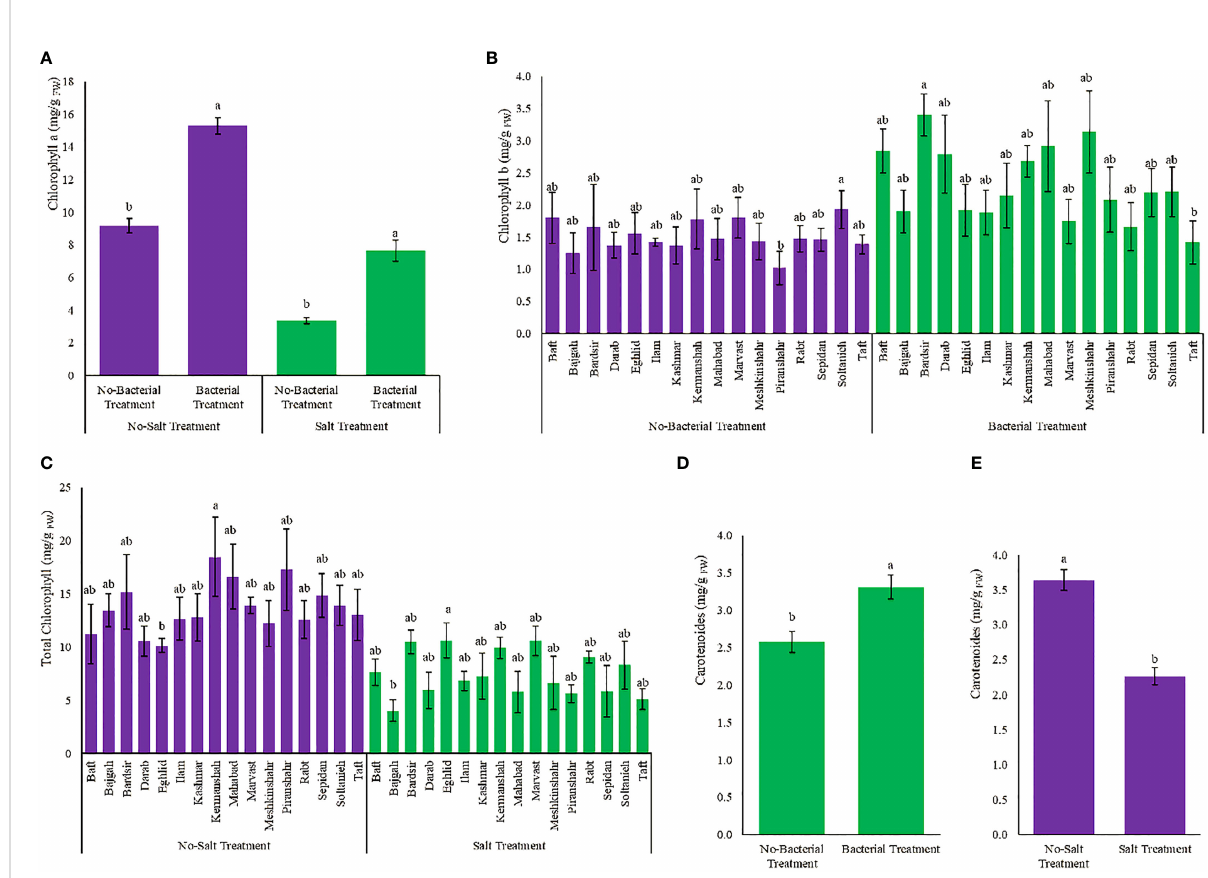
FIGURE 3 Measured parameters variation under studied treatments. (A) Chlorophyll a, (B) Chlorophyll b, (C) Total chlorophyll and (D, E) Carotenoid. According to the analysis of variance, the above present mean comparisons are the only effects that showed signi fi cant difference. Mean values with the same letters are not signi fi cantly different ( p ≤ 0.05), Tukey test. Bars stand for standard error